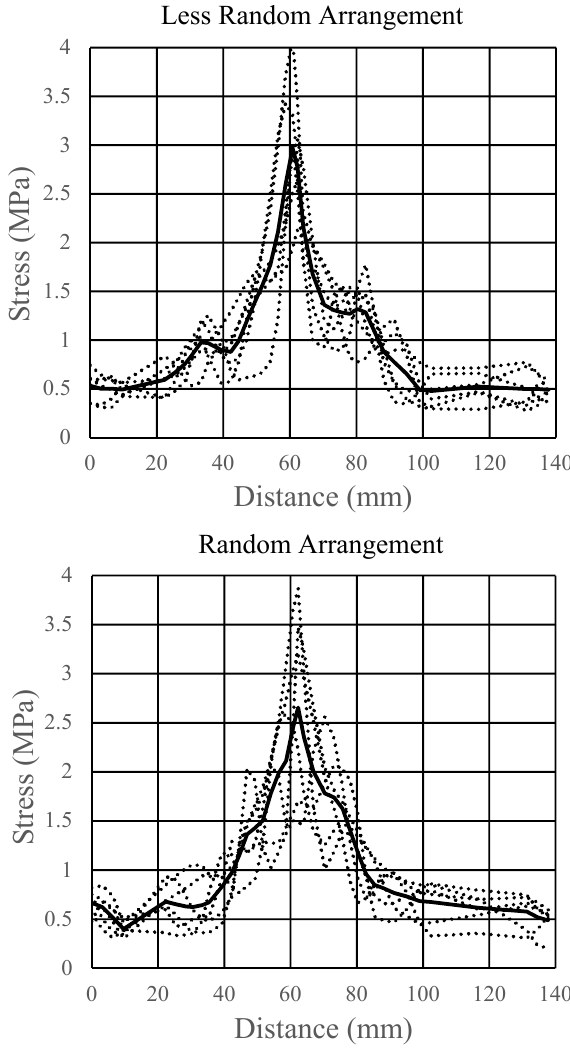
Figure 4. Horizontal linear stress path in front of the crack tip shown for each model in gray and averaged in black. The stress path is more concentrated along the crack path for the less random aggregate